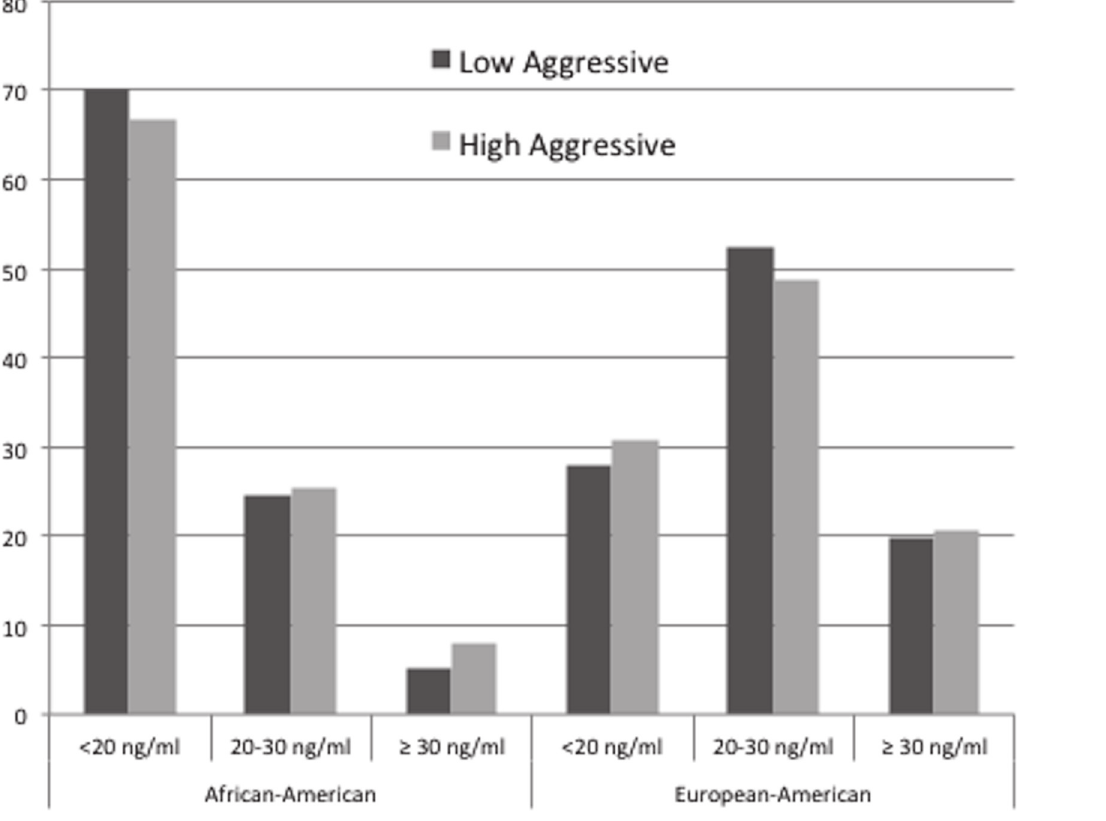
Fig 1. Distribution of plasma 25(OH)D3 by prostate cancer aggressiveness and